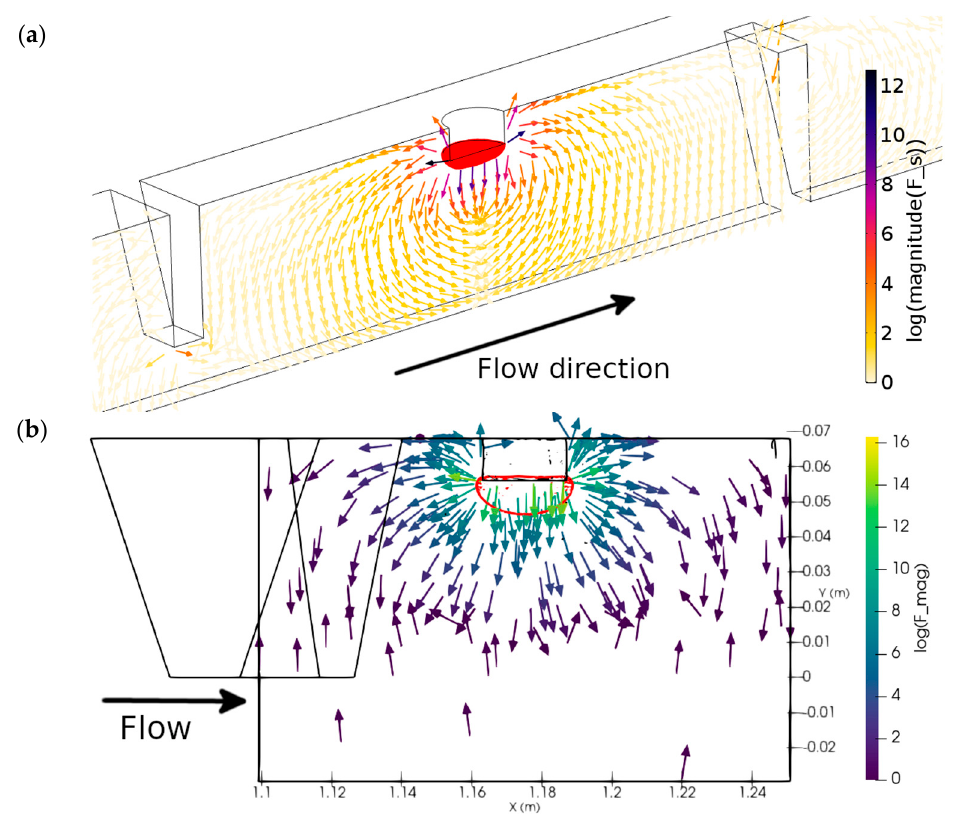
Figure 5. Magnitude of the induced acoustic streaming force when applying UST in the launder ( a ), and in the hot-top ( b ). 268